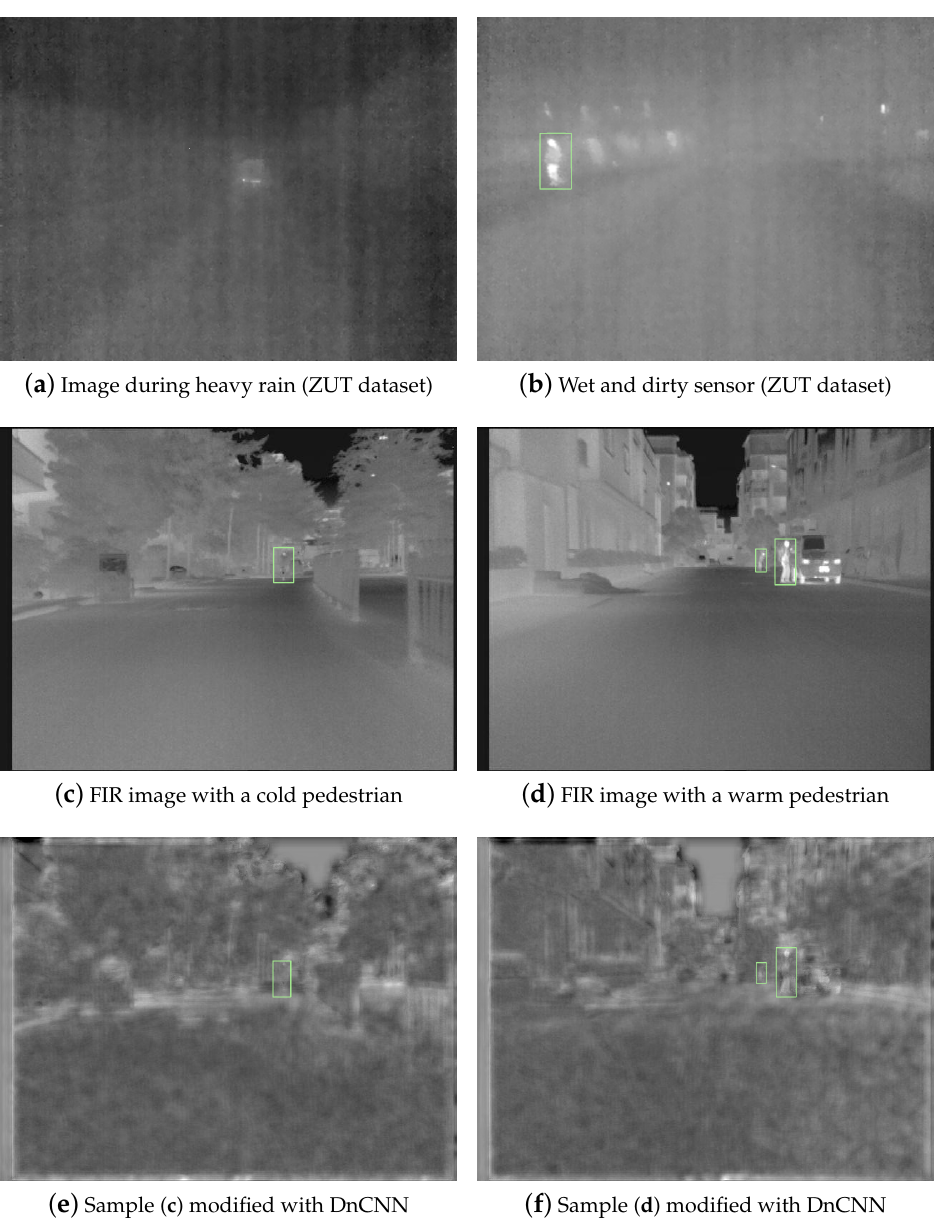
Figure 4. Comparison of captured and samples, augmented with DnCNN.